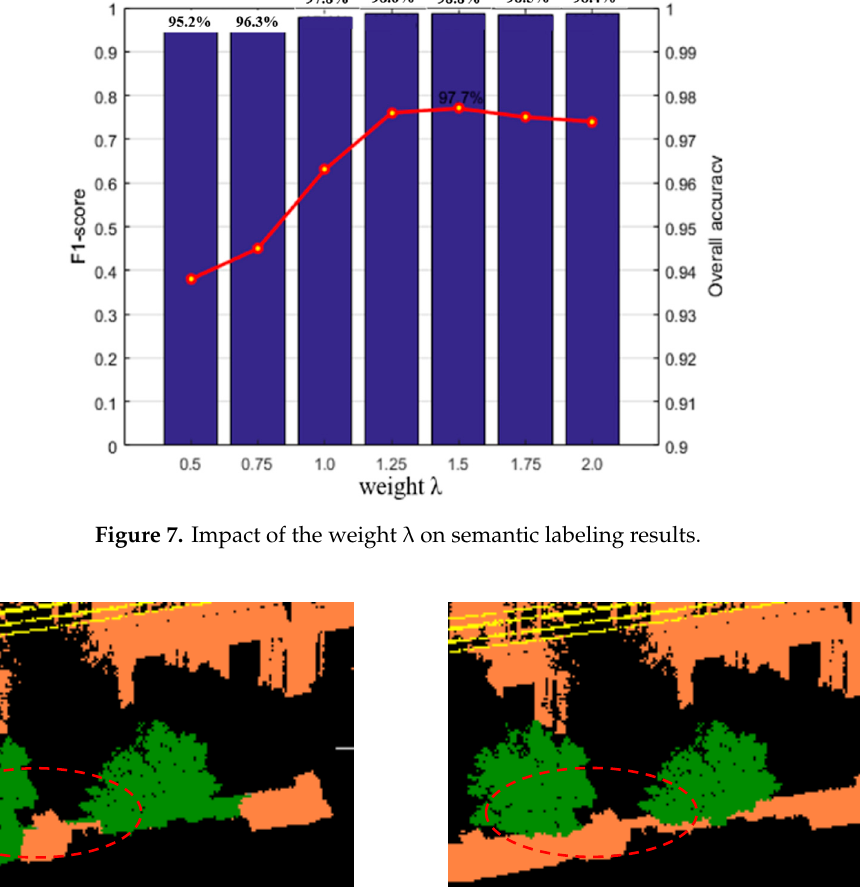
Figure 7. Impact of the weight λ on semantic labeling results.